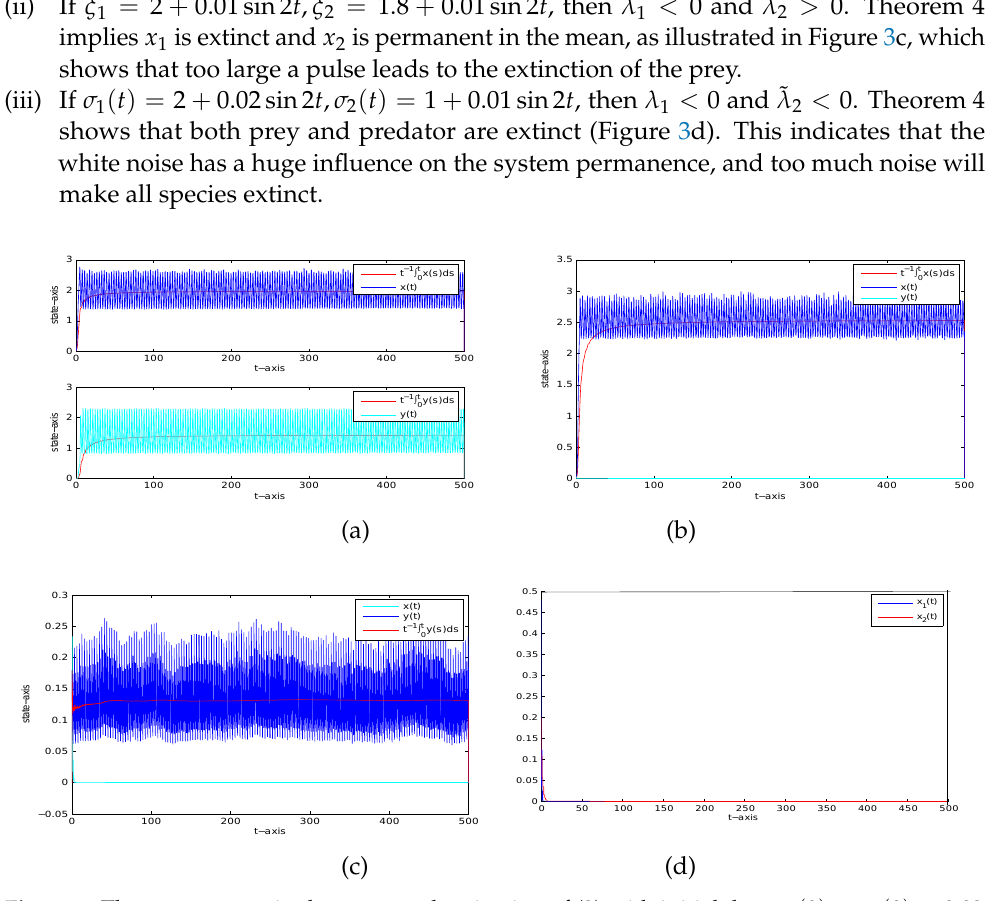
Figure 3. The permanence in the mean and extinction of (2) with initial data x 1 ( 0 ) = x 2 ( 0 ) = 0.02. ( a ) the time series graph of x 1 ( t ) and x 2 ( t ) ; ( b ) the permanence in the mean of x 1 ( t ) and extinction of x 2 ( t ) with σ 1 ( t ) = 0.02 + 0.02sin2 t , σ 2 ( t ) = 2 + 0.01sin2 t ; ( c ) the extinction of x 1 ( t ) and permanence in the mean of x 2 ( t ) with ξ 1 = 2 + 0.01sin2 t , ξ 2 = 1.8 + 0.01sin2 t ; ( d ) the extinction of all species with σ 1 ( t ) = 2 + 0.02sin2 t and σ 2 ( t ) = 1 + 0.01sin2 t